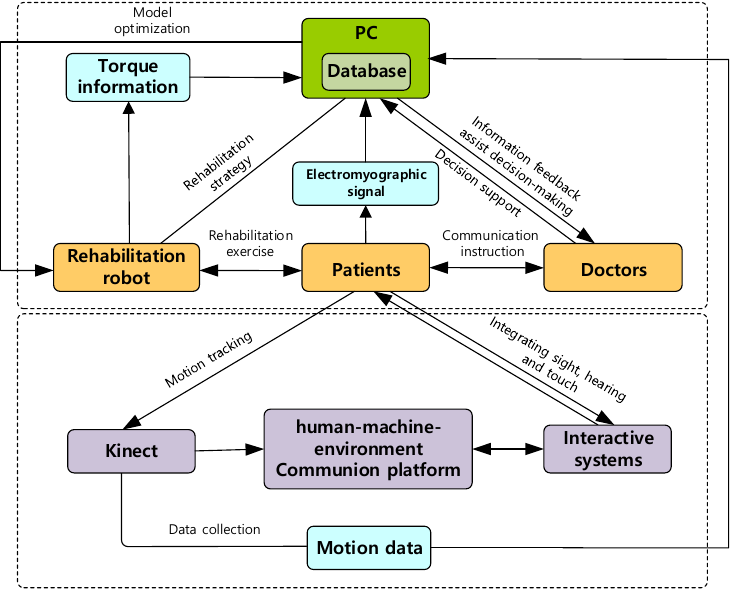
Figure 6. Kinect-based intelligent upper limb rehabilitation system.